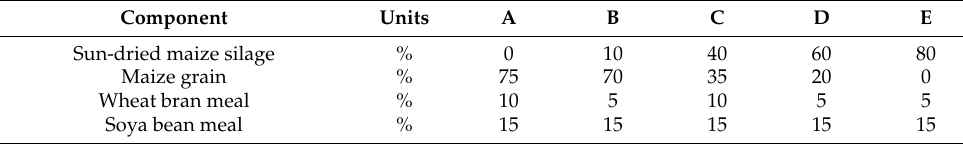
Table 1. Composition of feed (by mass) of ecological pig-raising systems (EPRSs). Component Units A B C